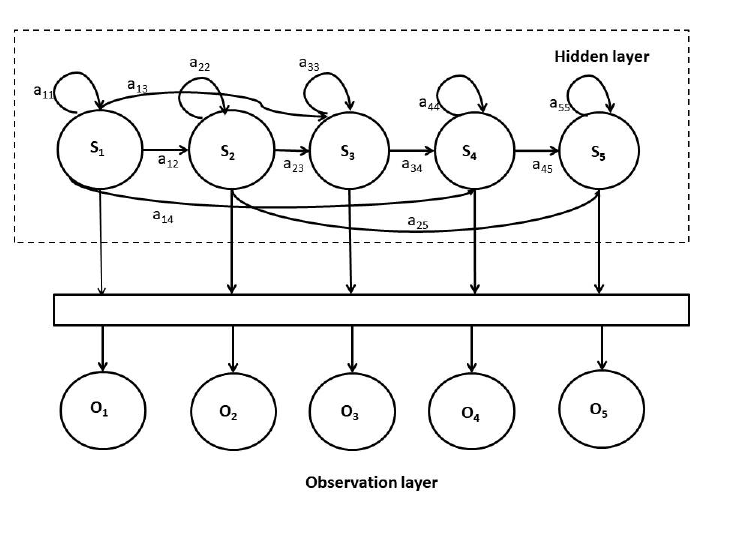
Figure 2. A five-State hidden Markov model (HMM)